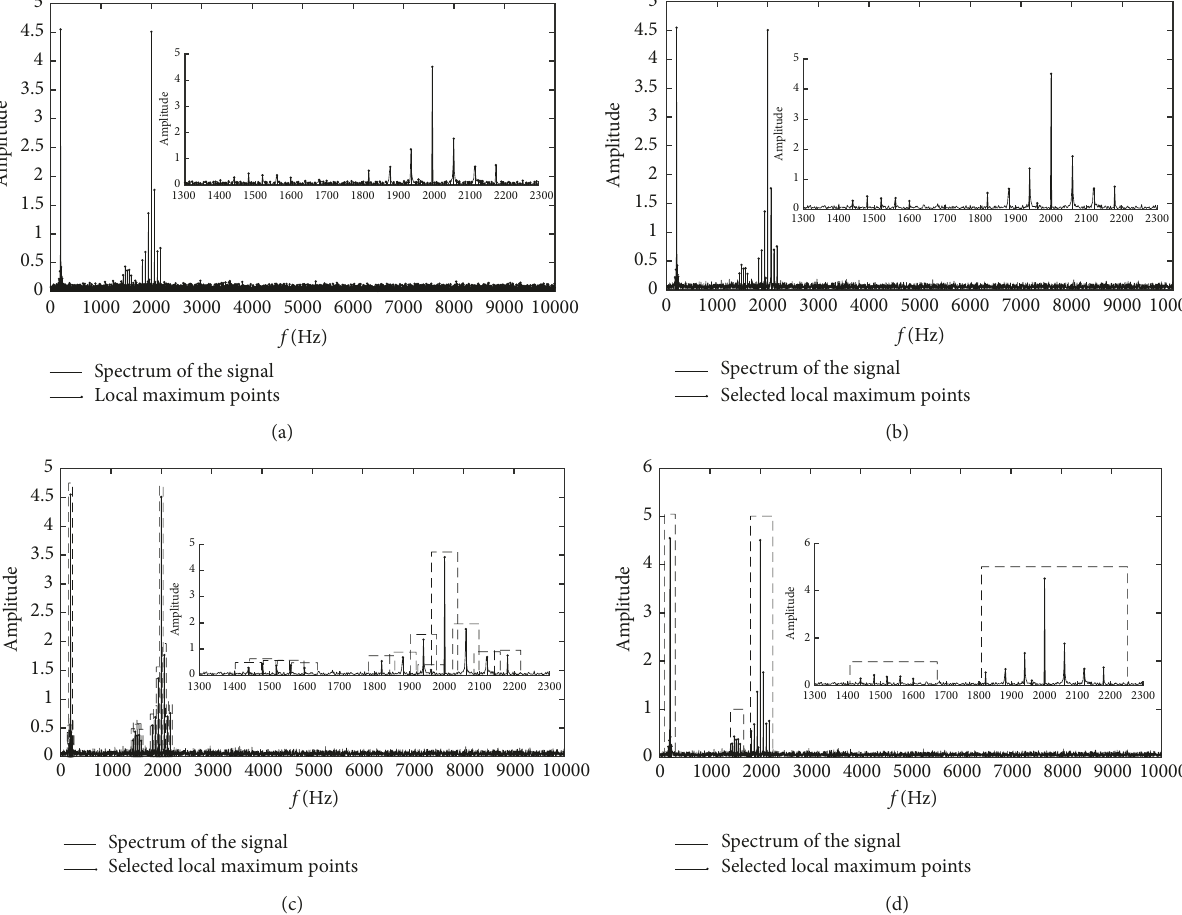
Figure 10: An example to illustrate the proposed adaptive SK method. (a) The spectrum of a signal and its local maxima. (b) The selected local maximum points. (c) The windows added around the selected local maximum points. (d) Merged window